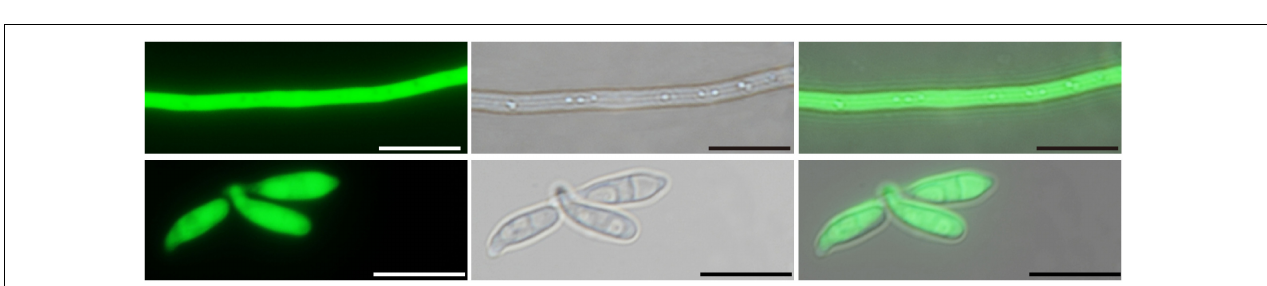
FIGURE 2 | Phylogenetic tree of six genes combined. The tree was inferred from the combined ITS, SSU, LSU, TEF1, MCM7, and RPB1 sequence datasets. The topology of the tree is the result of BI method. The value on the branch is the BI posterior probability (BIPP)/ML bootstrap proportion (MLBP). The Bar indicates 0.04 base substitution sites.